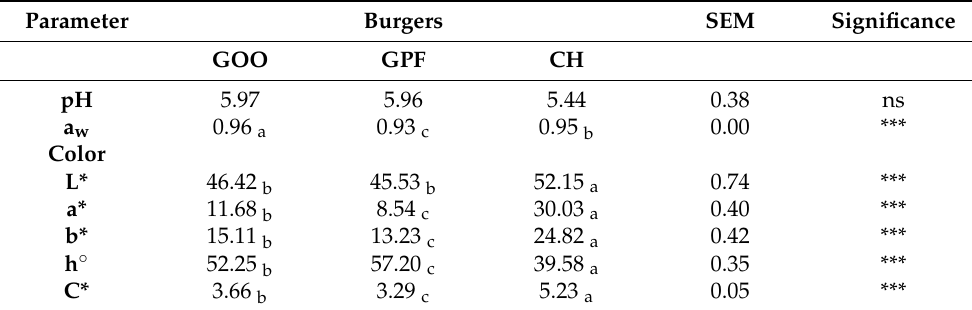
Table 2. Effects of fat replacement by olive oil on the pH, a w and color parameters of goat burgers as compared with commercial beef burgers.